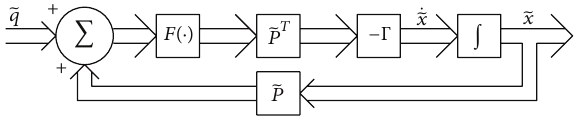
Figure 2: Block diagram of the GNN model (14).